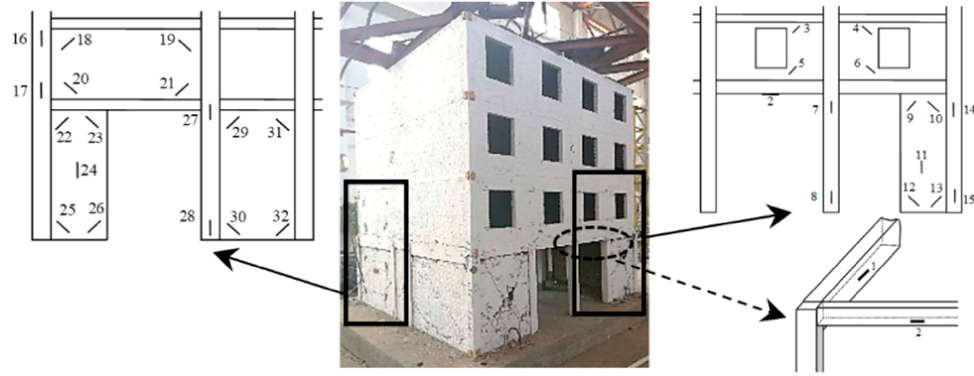
Figure 2. The bottom frame model, the layout of strain gauges and the cracking profiles.